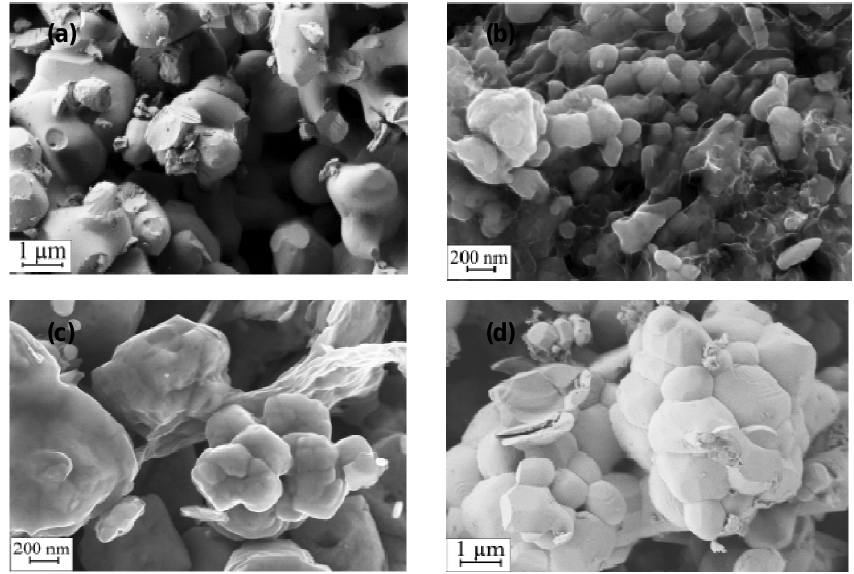
Fig. 2. SEM micrographs of the LFP-600-{I} (a), LFP/C-sucr-600-{I} (b), LFP/C-PAA-600-{I} (c), LFP/C-sucr- 800-{I}(d) samples.